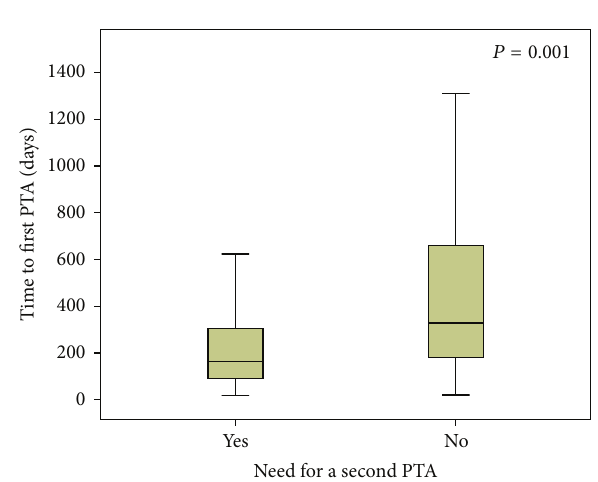
Figure 6: Time of primary PTA in patients who subsequently needed a second reintervention (Yes) and those who did not (No). An early primary PTA is more likely to require a reintervention than a late